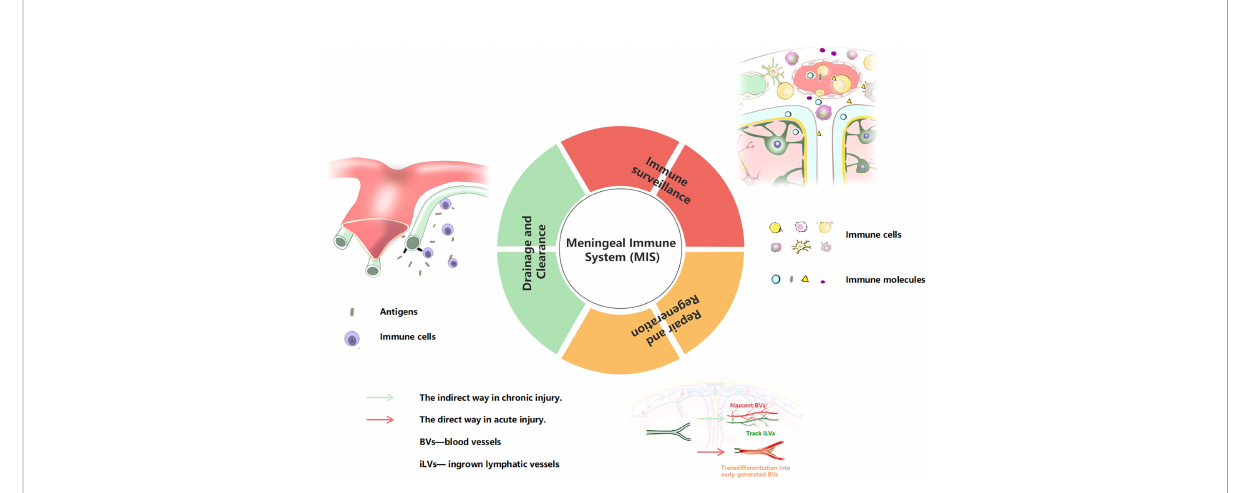
FIGURE 2 Summary of the MIS functions. BVs, blood vessels; iLVs , ingrown lymphatic